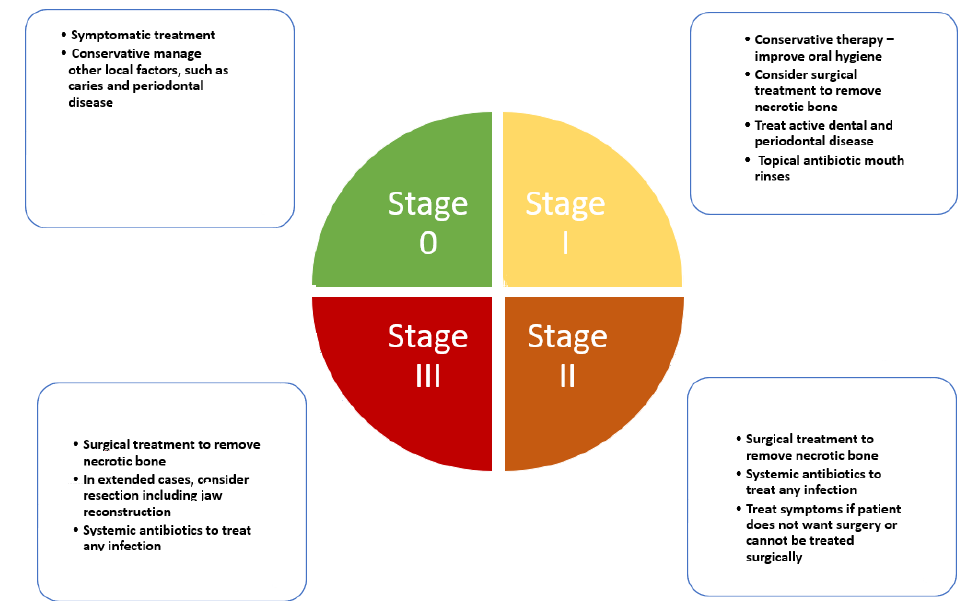
Figure 1. Clinical pathway for medication-related osteonecrosis of the jaw according to AAOMS latest update.